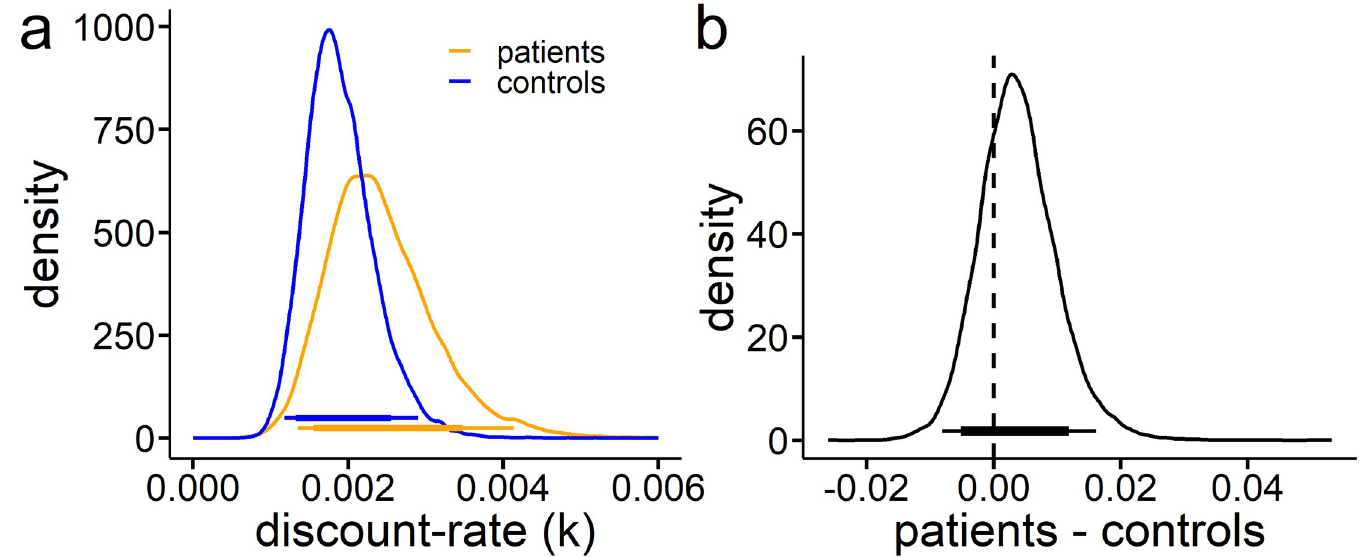
Fig 2. a , Group level hyperparameter distributions of discount-rate k for patients with TS (orange) and controls (blue); b Difference distribution of patients with TS—controls. The black bars indicate the 95% and 85% highest density interval respectively. Bayes factors for directional effects (dBF) of 0.36 patients > controls indicate no substantial difference between patients and controls. Thin and thick colored (a) and black (b) bars indicate the 95% and 85% highest density intervals respectively. TS, Tourette syndrome.